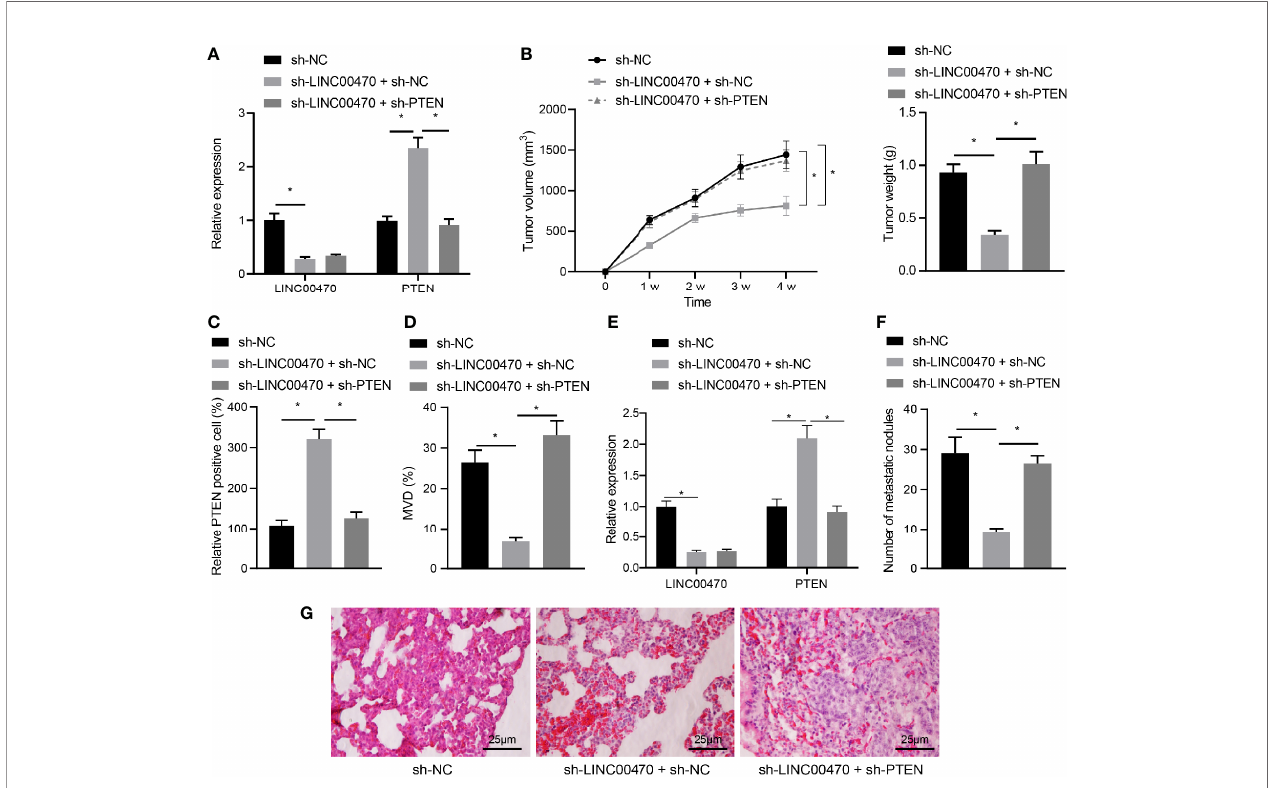
FIGURE 7 | Silencing of LINC00470 inhibited angiogenesis and metastasis of EC cells in vivo through PTEN. After knocking down LINC00470 and PTEN with lentivirus in KLE cells, the cells were injected to construct nude mouse tumor formation and metastasis models. (A) RT-qPCR determination of the expression of LINC00470 and PTEN in tumor tissues of mice from the tumor formation model. (B) Growth curve, solid map, and weight of tumors after knocking down LINC00470 and PTEN. (C) The expression of PTEN in tumor tissues after knocking down LINC00470 and PTEN assessed by IHC. (D) Microvessel density after knocking down LINC00470 and PTEN. (E) LINC00470 expression in tumor tissues of mice from the tumor metastasis model determined by RT-qPCR. (F) Visual observation of lung metastasis and counting of nodules after knocking down LINC00470 and PTEN. (G) Lung metastasis after knocking down LINC00470 and PTEN examined by HE staining, scale bar = 25 m m. The experimental data were expressed as mean ± standard deviation, and t -test was used for data comparison between two groups. One-way ANOVA and Tukey ’ s post hoc test were used for comparison among multiple groups, and repeated measures ANOVA was used for data comparison at different time points followed by Bonferroni ’ s post hoc test. * p < 0.05, N =